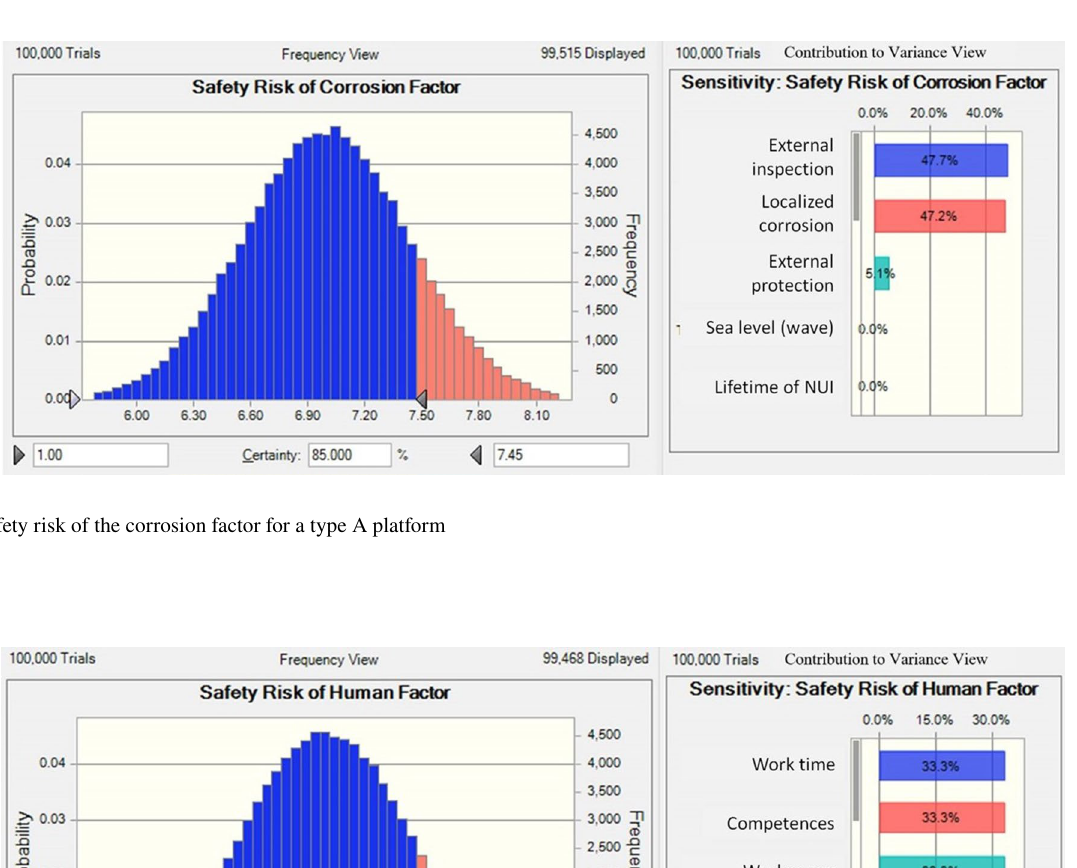
Fig. 2 Safety risk of the environmental effect for a type A platform